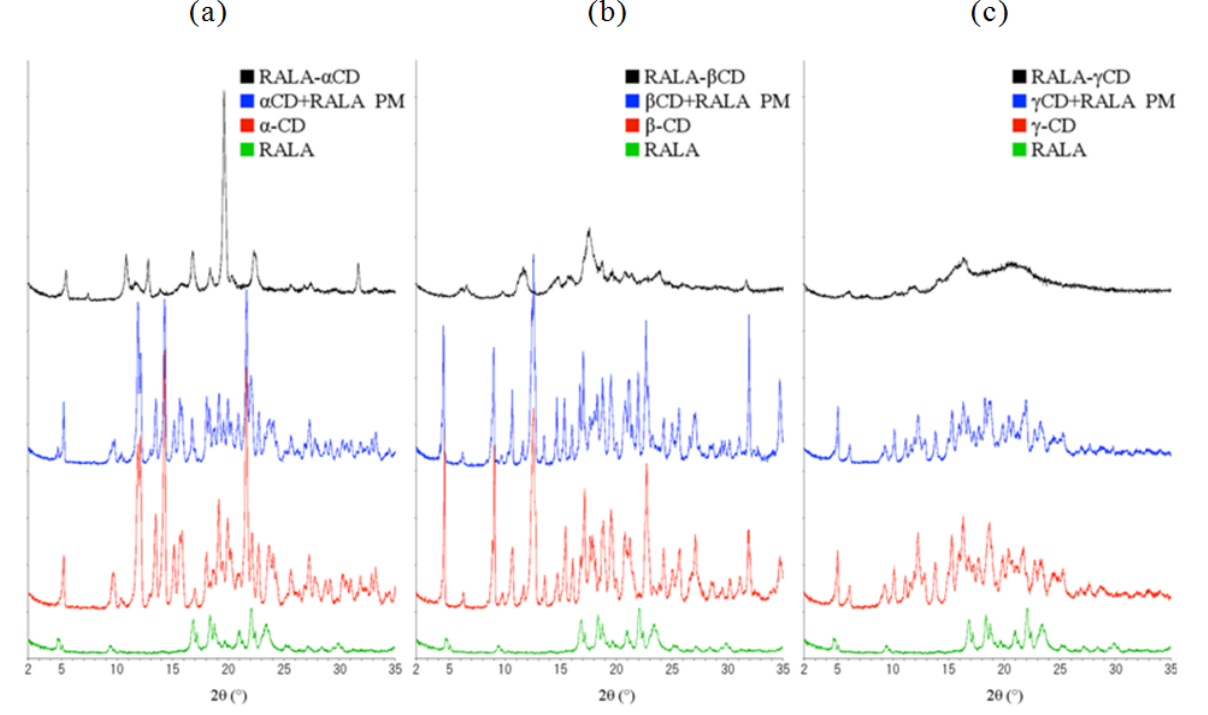
Figure 7. XRD patterns of the RALA- α CD, - β CD and - γ CD complexes, their physical mixtures (PM), CD and free RALA. ( a ) α -CD, physical mixture, RALA- α CD and free RALA, ( b ) β -CD, physical mixture, RALA- β CD and free RALA and ( c ) γ -CD, physical mixture, RALA- γ CD and free